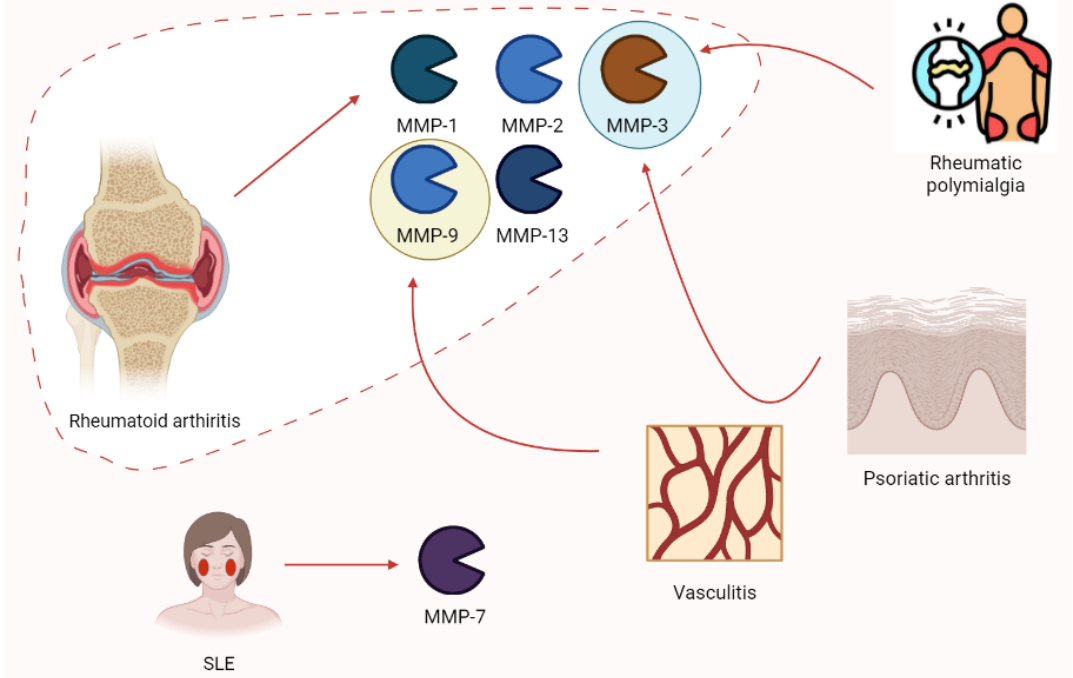
Figure 10. The expression of some of the main MMP isoforms in rheumatologic diseases is relevant to pathogenesis. Rheumatoid arthritis is characterized by the increases in MMP-1, -2, -3, -9, and -13. Nevertheless, other clinical conditions such as rheumatic polymyalgia, psoriatic arthritis, vasculitis, and SLE show this phenomenon. SLE, systemic lupus erythematosus.